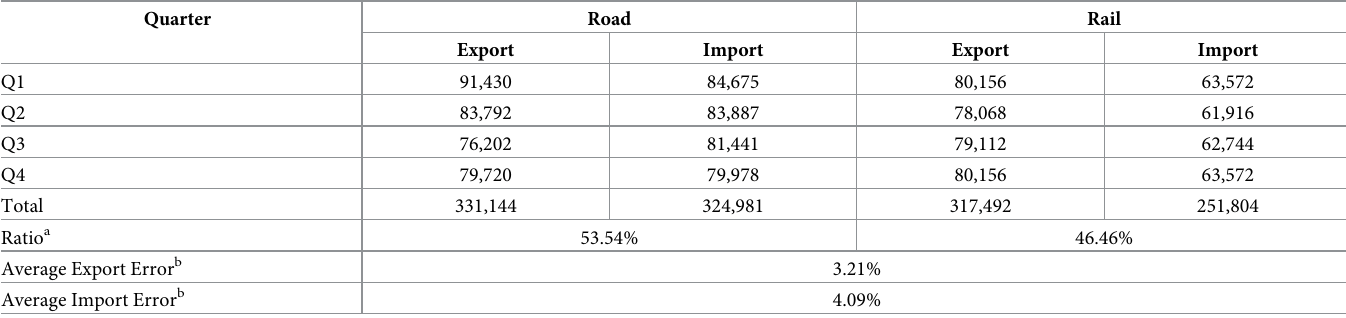
Table 6. Simulated container flows of the new LICD obtained from SIMIO (S3), together with the average margins of error for both import and export containers.